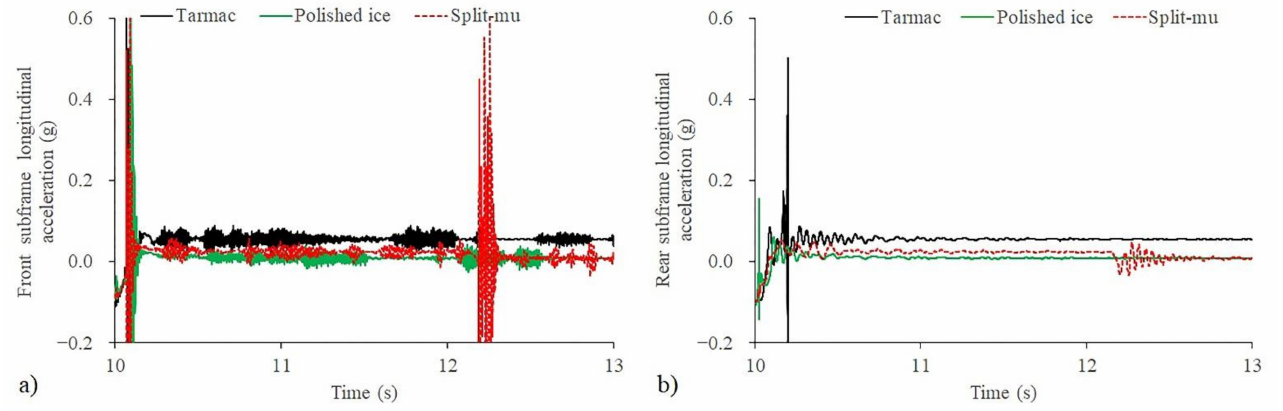
Figure 9. Tip-in event longitudinal acceleration on different road mu: ( a ) front subframe; ( b ) rear